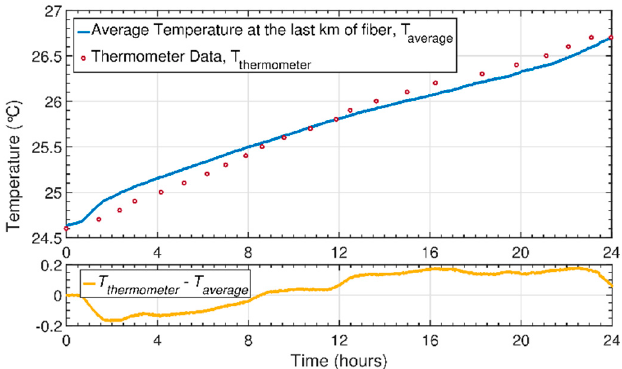
Figure 8. Temporal evolution of the average temperature in the last kilometer of fiber vs. the registered temperature with a thermometer over a period of 24 h. Below, the difference between the two traces is represented, after a linear interpolation was performed to the thermometer data.